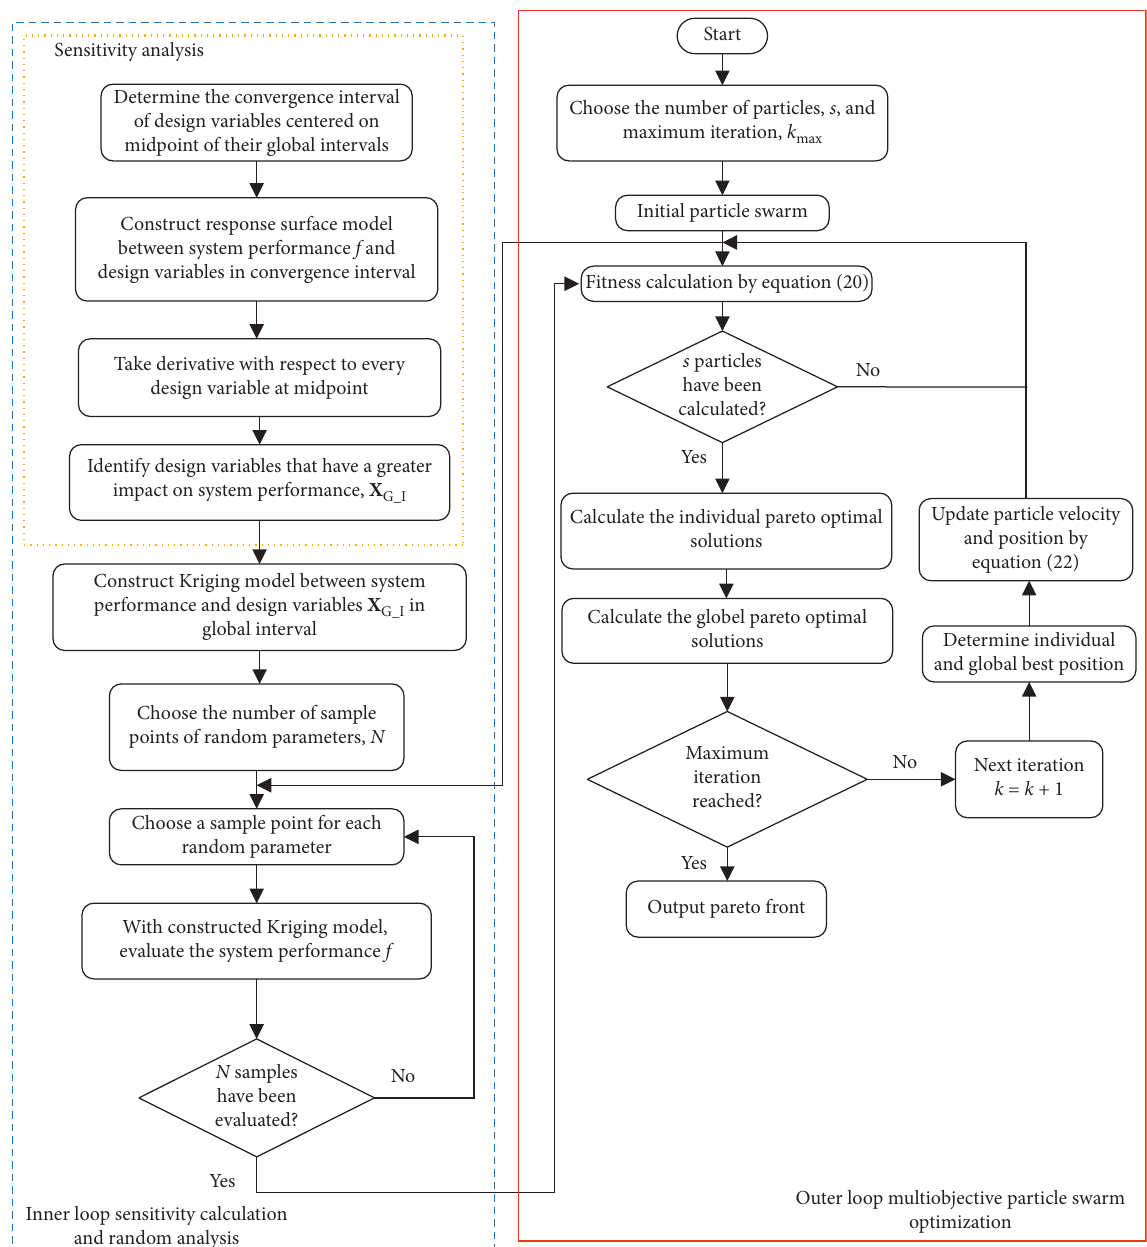
Figure 4: Flowchart of multiobjective robust optimization strategy integrating sensitivity analysis, Kriging surrogate model, RSM, MC method, and